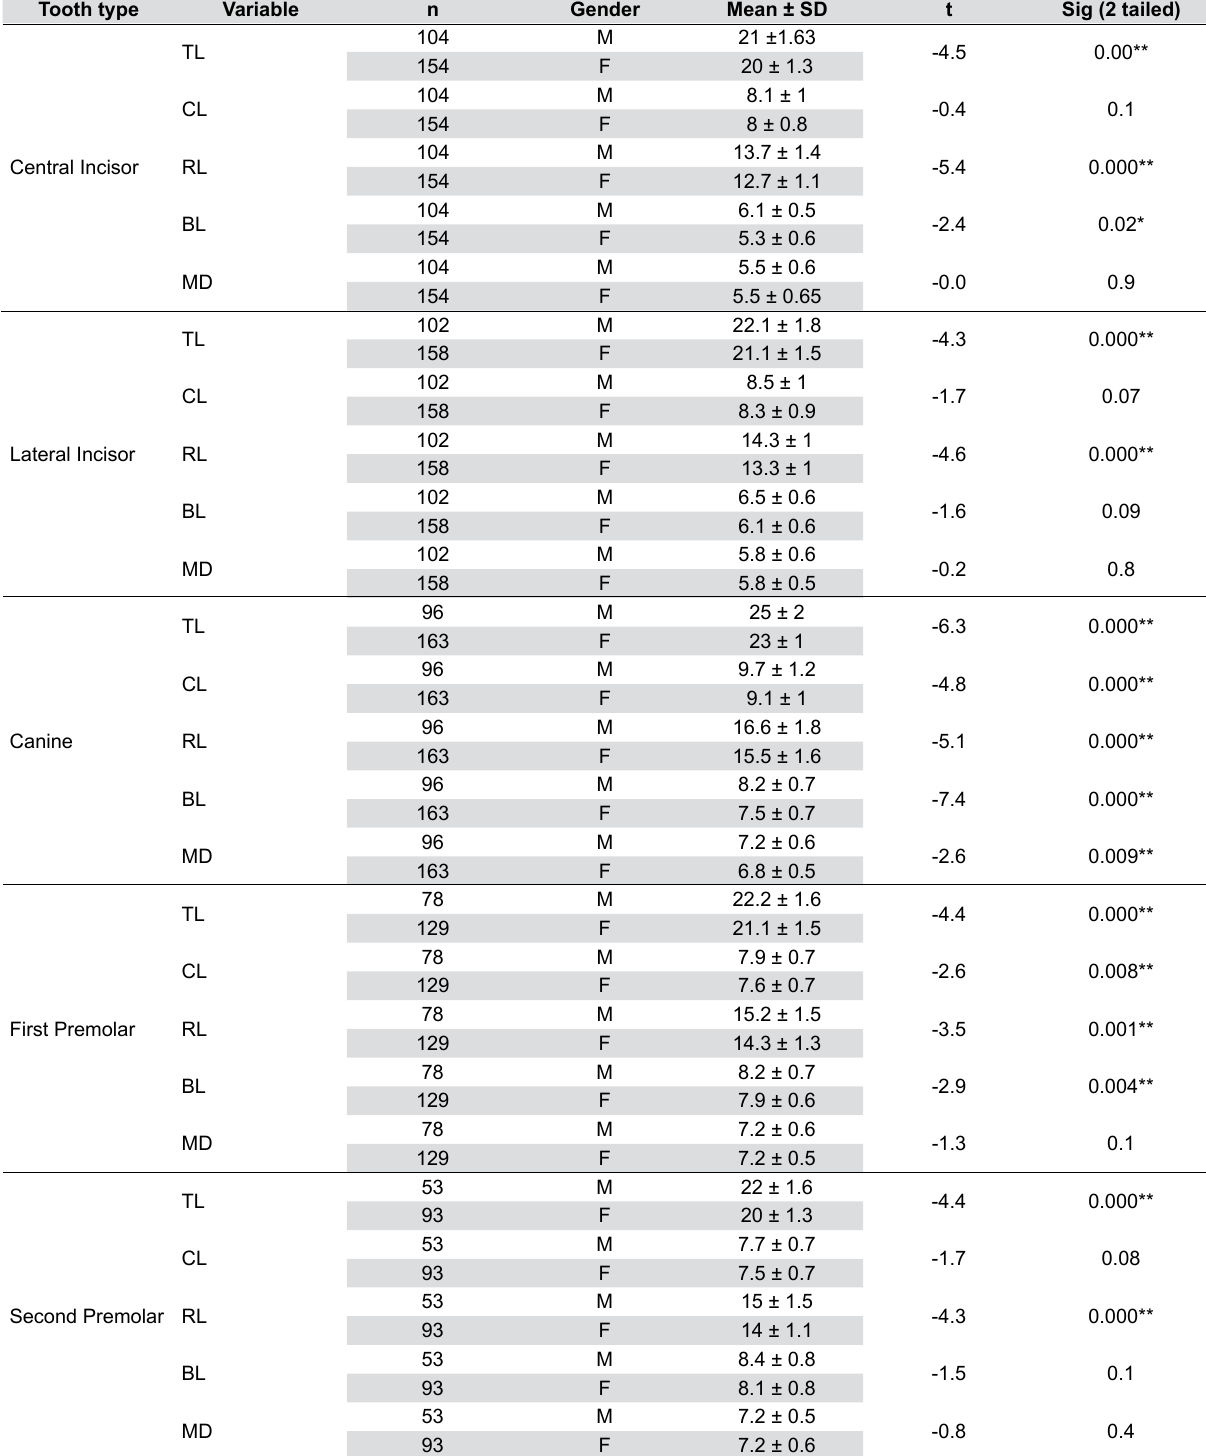
Table 2- Comparison of the tooth length measurements between male and female subjects